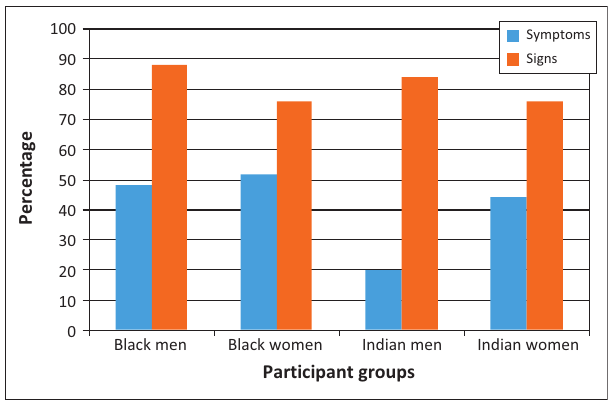
FIGURE 1: Prevalence of symptoms and signs amongst participant groups ( N = 25 for each group).